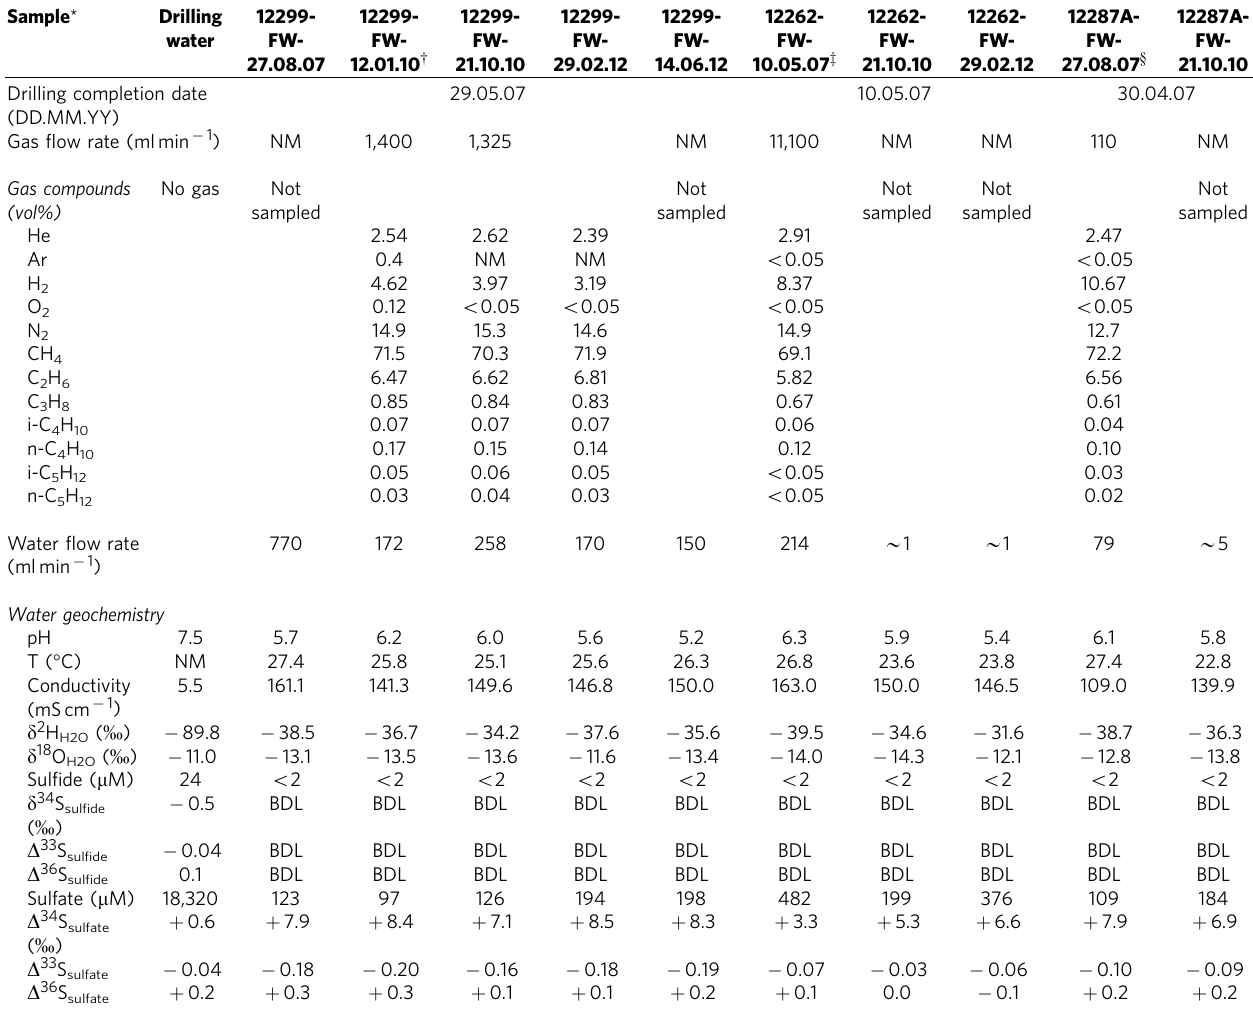
Table 1 | Geochemical and isotopic characterization of fracture waters and dissolved sulfur species. Sample * Drilling